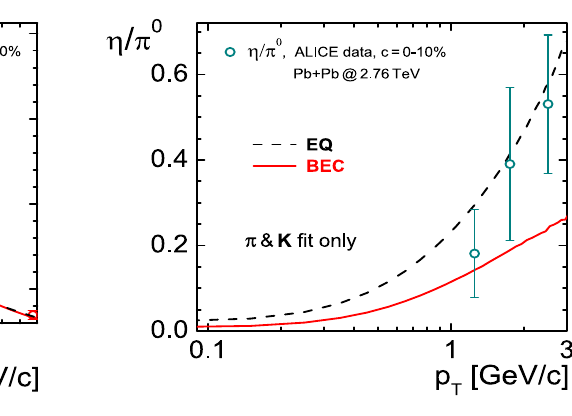
Figure 1. Temperature and non-equilibrium pion chemical potential, µ π = 2 T ln γ q , in Pb + Pb at 2.76 TeV [6, 7]. Figure 3. Low p T charged pions and η/π 0 in EQ and BEC.